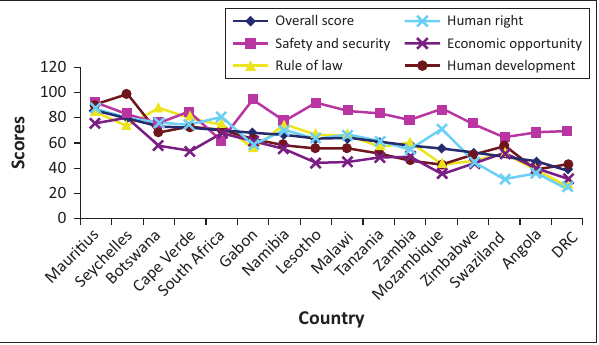
FIGURE 1: Ibrahim index of African